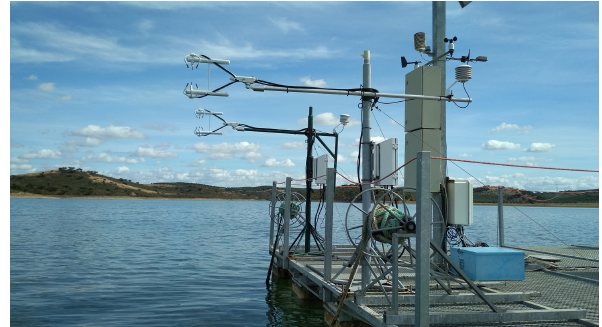
Figure A1. The instruments installed in Alqueva reservoir (Portu- gal) for the intercalibration. The left instrument belongs to the Insti- tute of Earth Sciences, University of Évora, and the instrument on the right belongs to the Finnish Meteorological Institute.